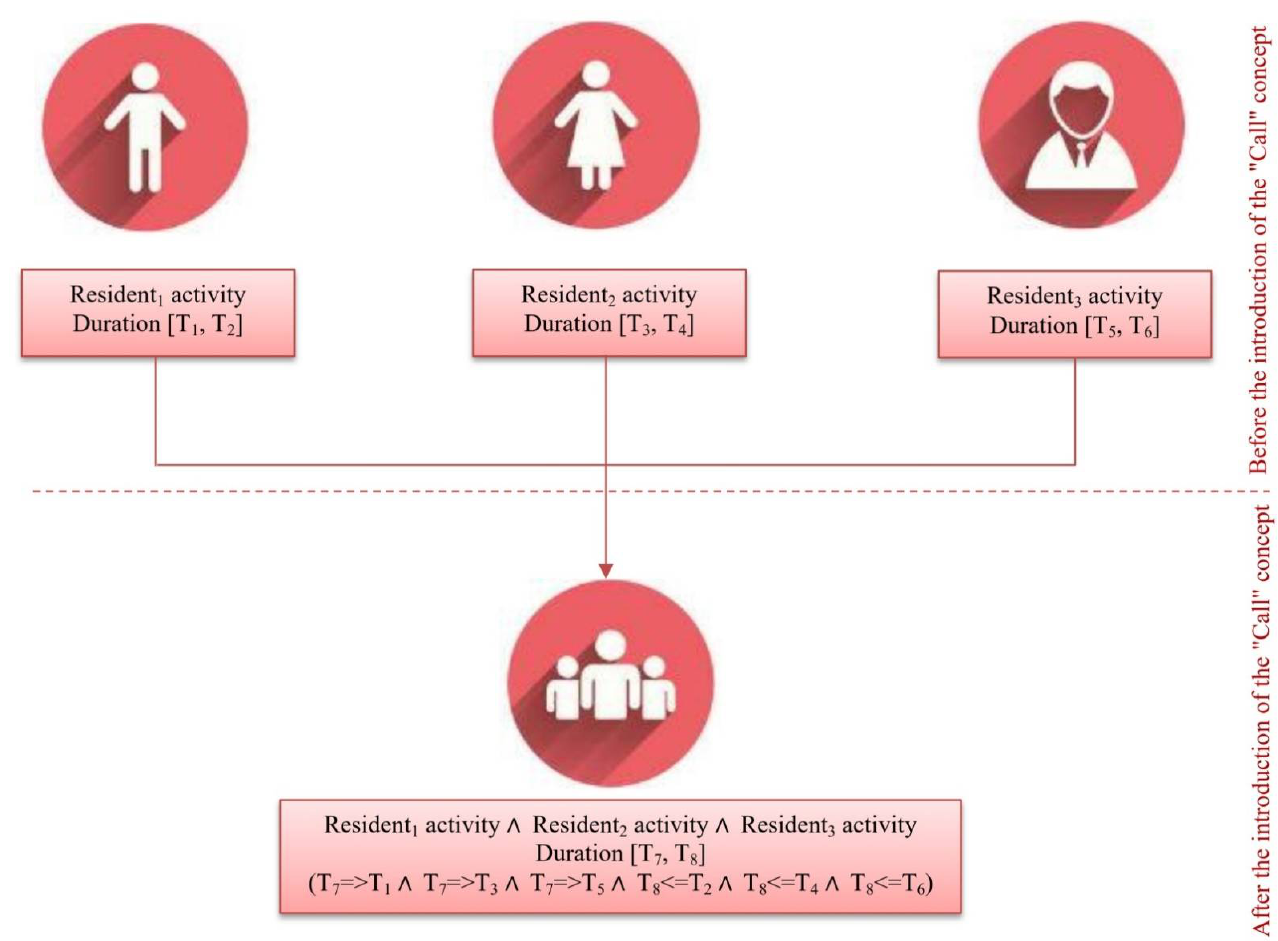
Figure 3. Impact of the introduction of the “Call” concept in IRRHEM.